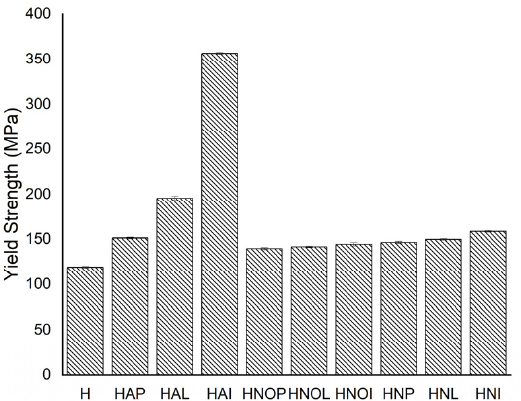
Figure 2. Evolution of yield strength values of the experimental 5083 alloy samples, in different structural states.